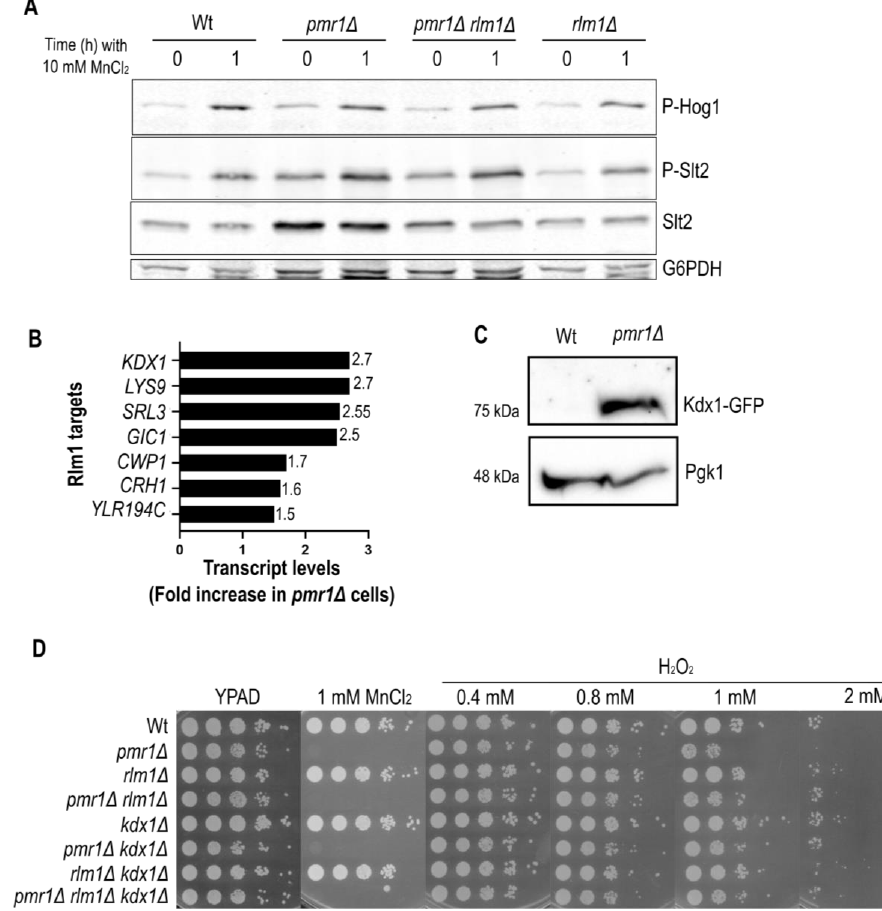
Figure 5. Slt2-downstream targets are up-regulated in cells lacking Pmr1. ( A ) Exponentially growing Wt and indicated mutant strains were treated for up to 1 h with 10 mM MnCl 2 . The levels of Slt2, phosphorylated Slt2 (P-Slt2) and Hog1 (P-Hog1) were analyzed by immunoblotting as in Figure 4. Glucose-6-phosphate dehydrogenase (G6PDH) was used as a loading control. ( B ) Up-regulation of Rlm1 target gene transcripts in pmr1 ∆ mutants and ( C ) Kdx1-GFP protein level, analyzed by immunoblotting with anti-GFP antibodies, in Wt and pmr1 ∆ mutants. Pgk1 was used as loading control. ( D ) The growth of 10-fold dilutions of exponentially growing cells is shown. Strains, MnCl 2 and H 2 O 2 concentrations are indicated. The pictures were taken after 2 days of